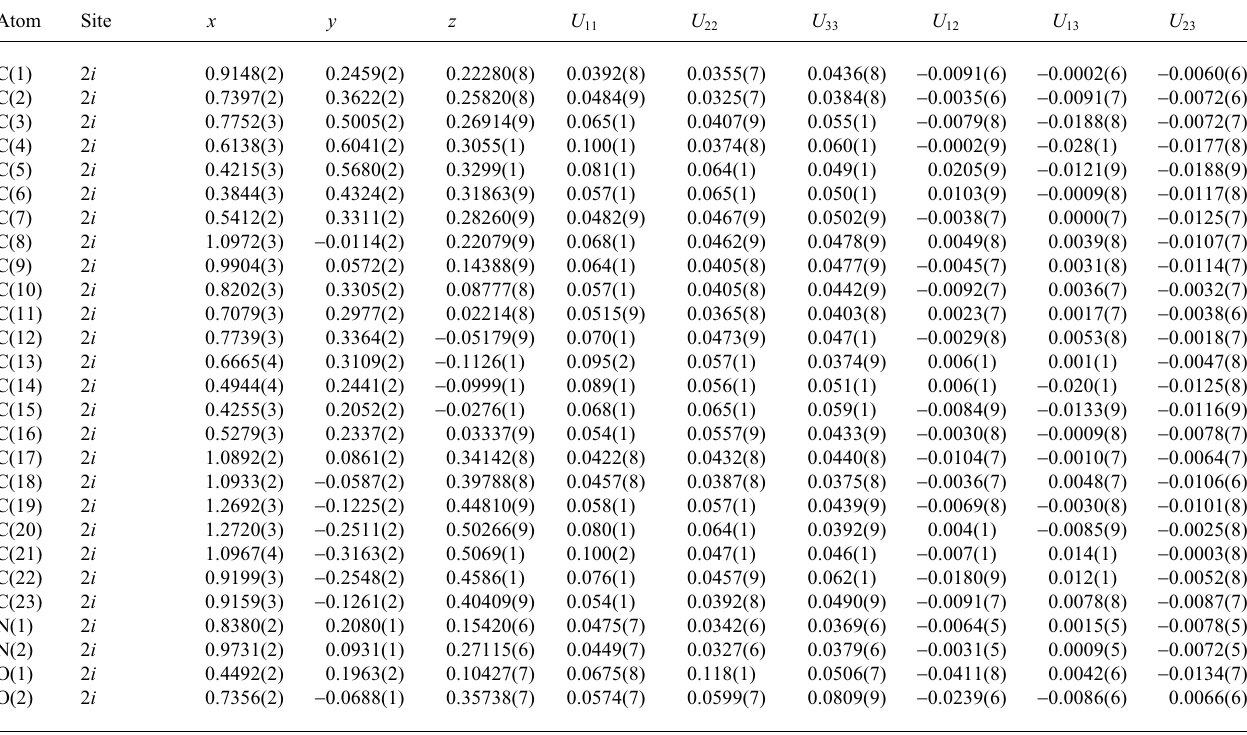
Table 3. Atomic coordinates and displacement parameters (in Å 2 )